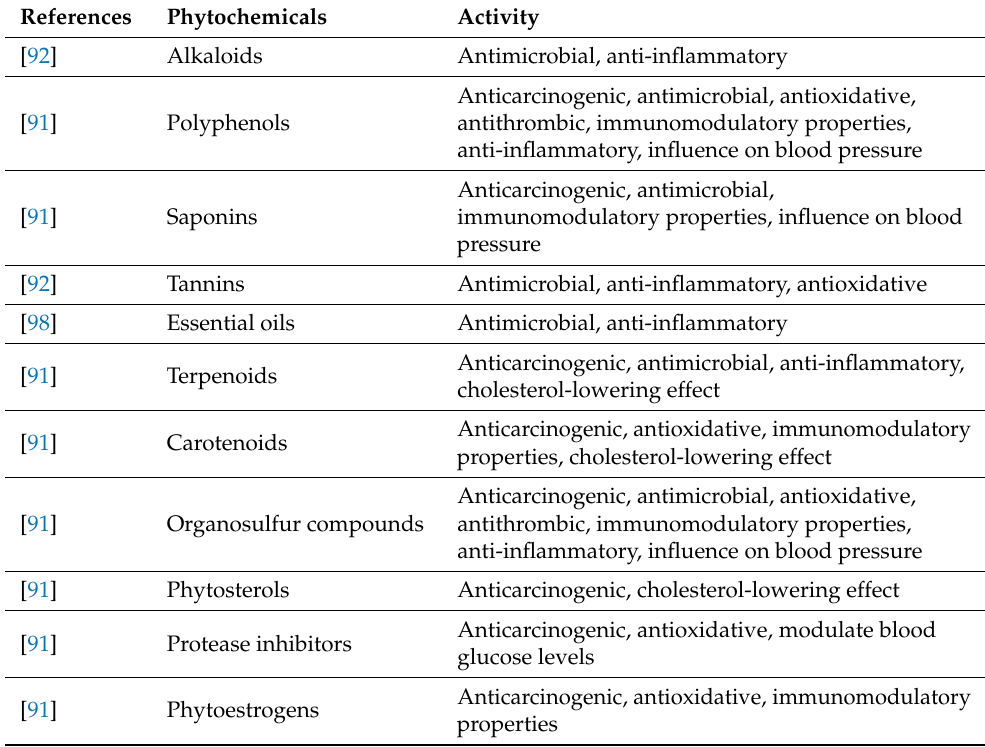
Table 2. Classification of phytochemicals and their main